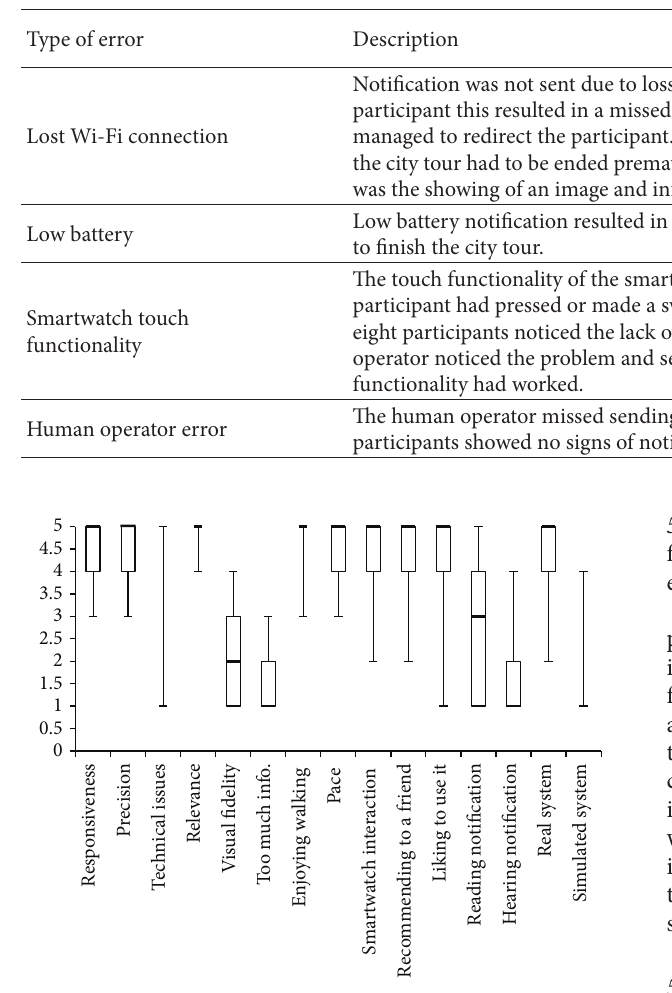
Figure 8: Median and the whiskers show the range of the data